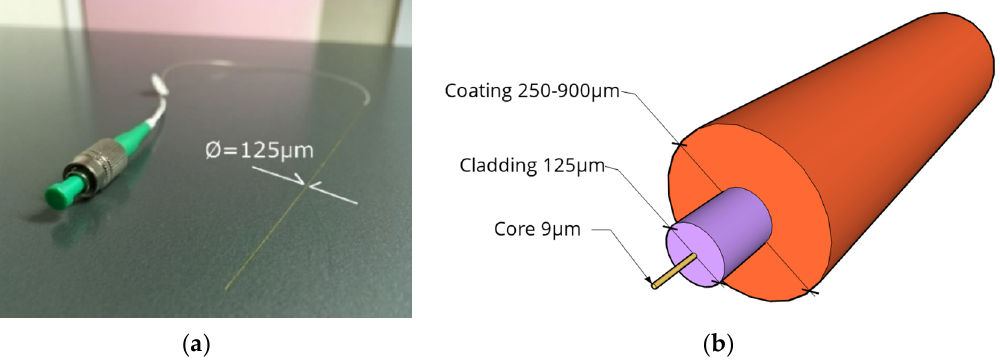
Figure 1. Optical Fiber Sensors: ( a ) a picture of the fiber and a ( b ) 3D illustration of its cross-section— note that the latter is of an indicative nature only as many kinds of differently coated OFS are available on the market [19].